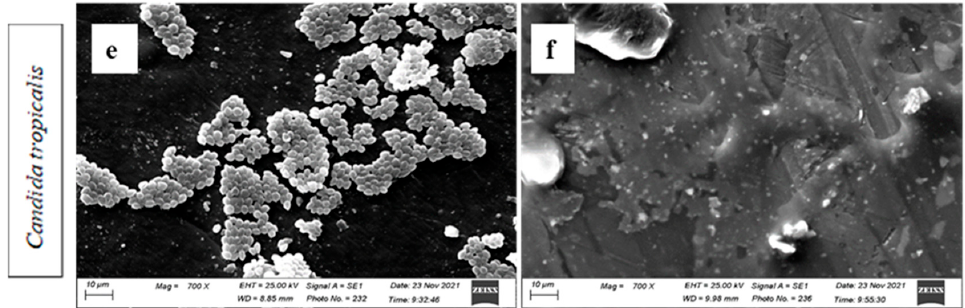
Figure 7. SEM micrographs of Staphylococcus aureus, Klebsiella pneumonia, and Candida tropicalis